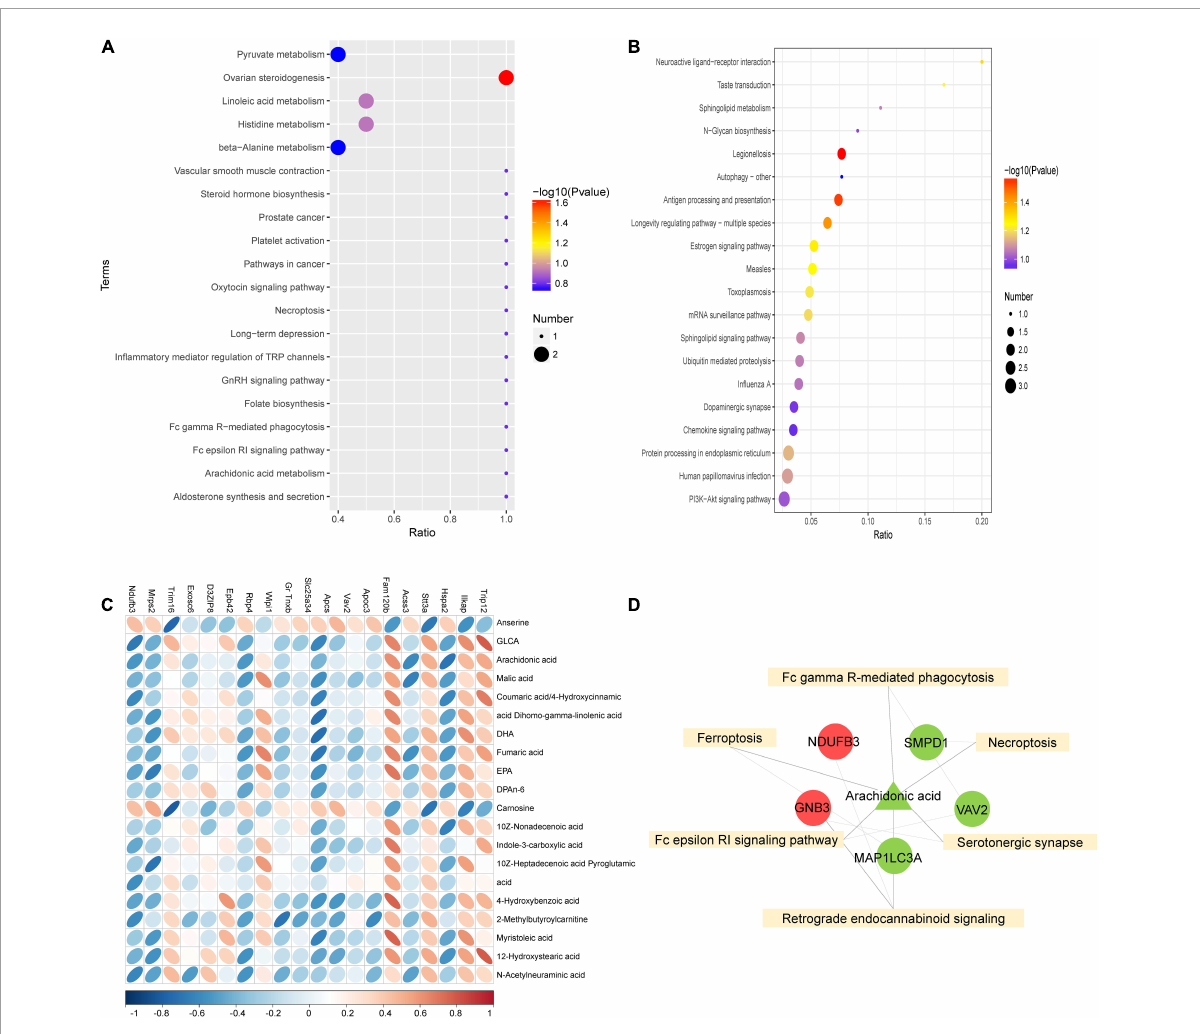
FIGURE5 Combined analysis of differential proteins and differential metabolites. (A,B) KEGG enrichment bubble diagram of differential proteins (A) and differential metabolites (B) in groups EMPA and HG. (C) Heat map of correlation between differential protein and differential metabolite expression. The horizontal axis represents proteins, and the vertical axis represents metabolites. (D) Combined analysis of pathway enrichment of differential protein and metabolites. The yellow square represents the pathways shared by differential metabolites and differential proteins, and the circles and triangle represent the differential proteins and differential metabolites involved in the pathway, respectively. Circles represent differential proteins, triangles represent differential metabolites, red is represent up-regulated and green is